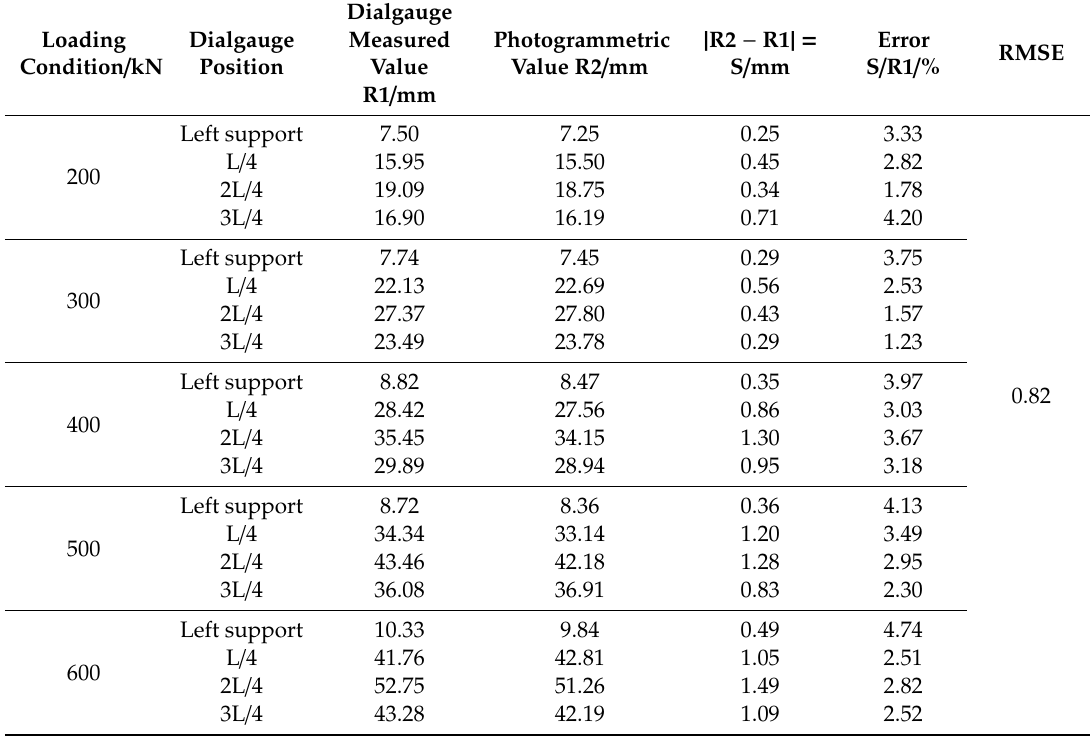
Table 4. Comparison of displacement measurement